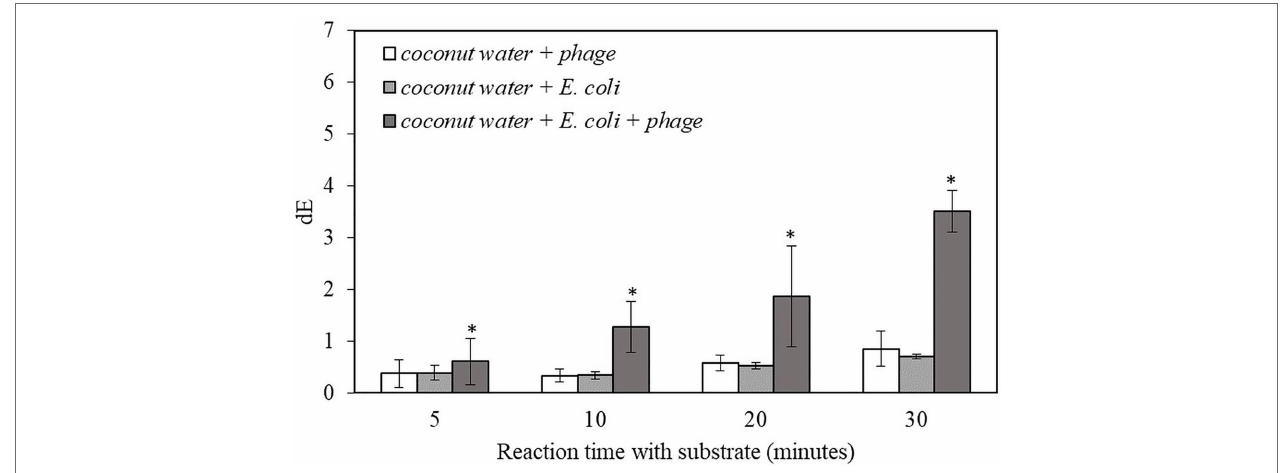
FIGURE 3 | The dE value of the filter with bacteriophage T7-ALP in TSB-coconut water mixture, 5-h enriched 10 CFU/ml E. coli BL21 and 30 min with and without infection with bacteriophage T7-ALP in TSB after enzymatic reaction with NBT/BCIP for 5, 10, 20, and 30 min. Treatments with “ * ” are significantly different ( p < 0.05). Error bars indicate ±standard deviation of means.